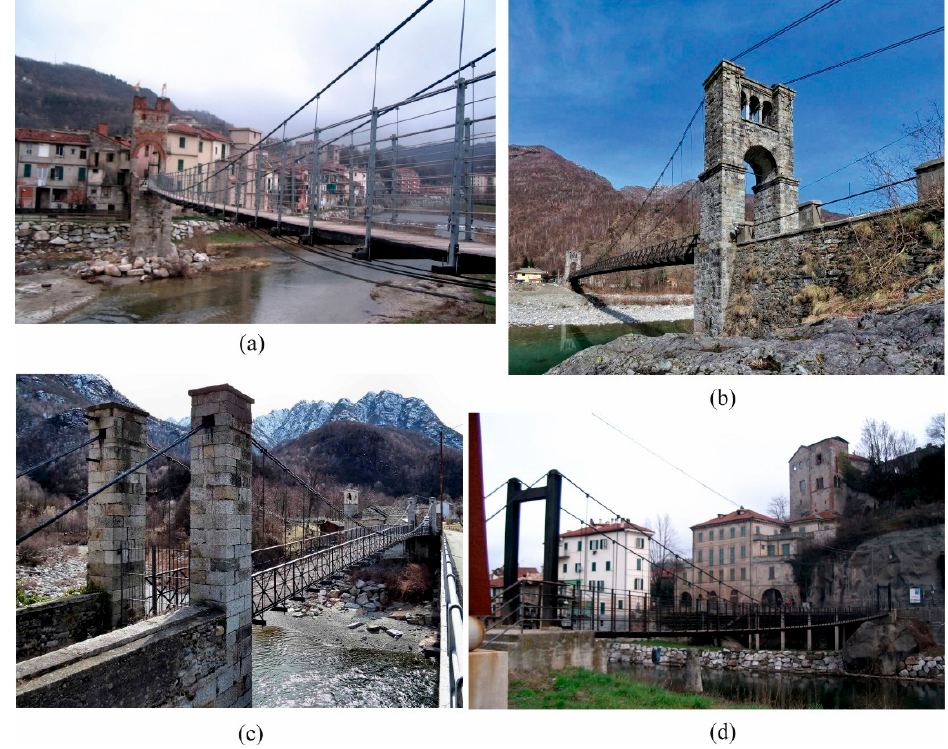
Figure 1. ( a ) Footbridge “Gaietta”, Millesimo, Italy (photo by F. Venuti); ( b ) Morca bridge, Italy; ( c ) Footbridge of Vocca Island, Italy; ( d ) Footbridge at Millesimo, Italy (photo by F. Venuti).